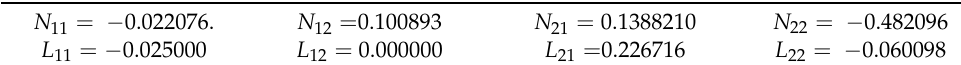
Table 12. Two-group reflected reactor fluxes coefficients.